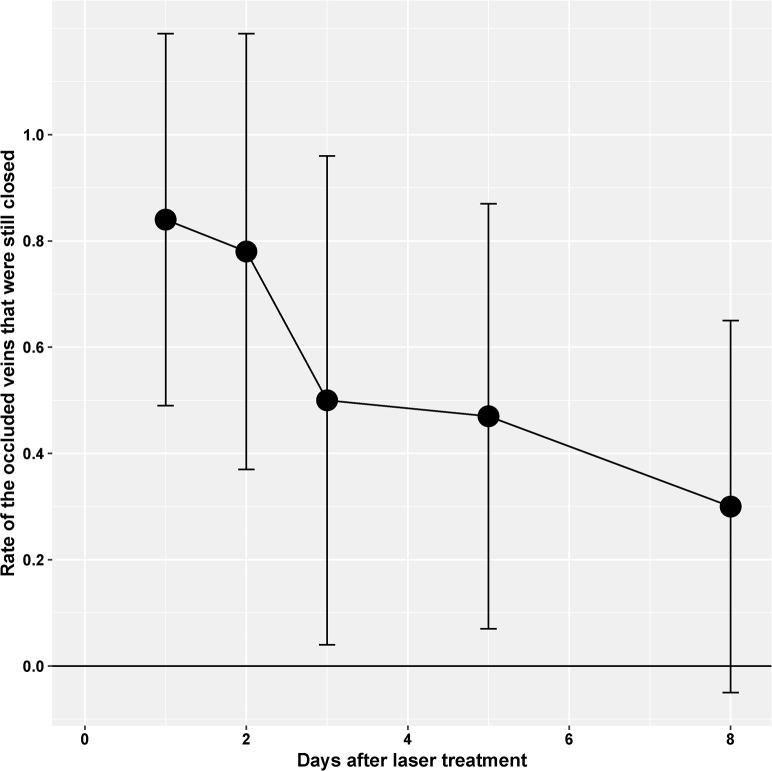
Time course of occlusion.RVO was evaluated in fundus images and by angiography. The diagram shows the mean rate of occluded veins that were still closed at the respective day. Veins were assumed to be occluded if there was a visible thrombus, an interruption in blood flow, a difference in vessel caliber (central constriction, peripheral dilation), leakage, tortuositas, or neovascularization. Half of the veins were re-opened after three days. Error bars indicate standard deviation. The values are from 15–17 retinae of the same animals used for the qPCR and RNAseq experiments.